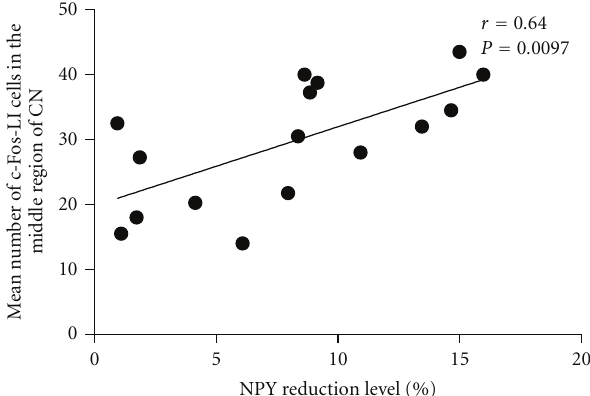
Figure 8: Linear regression of the mean number of c-Fos-LI cells and NPY reduction level in the CN four weeks after chronic constriction injury (each point represents an individual animal; r 0 . 64, P 0 . 01). (cid:2) (cid:0)